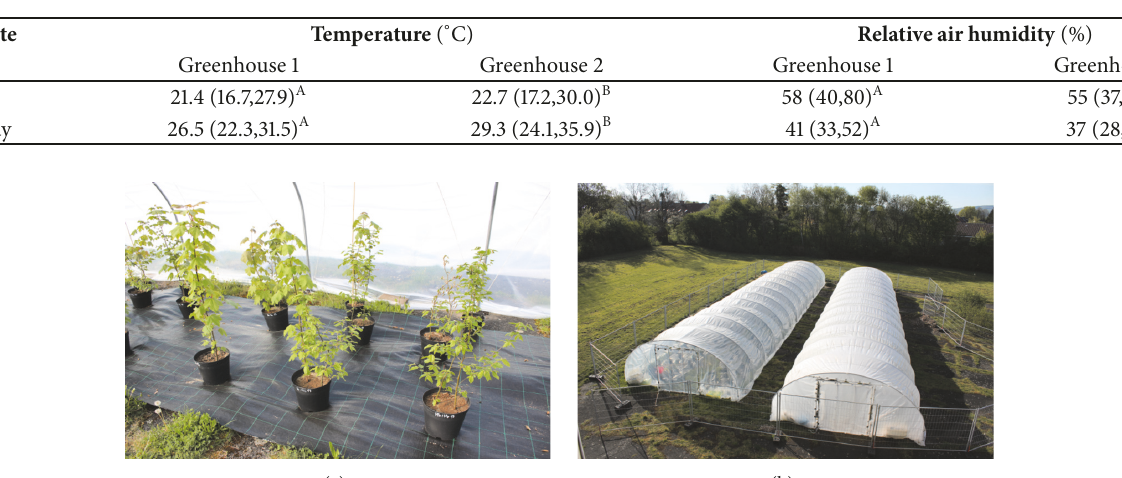
was used as the mean per individual for further analyses of leaf toughness.